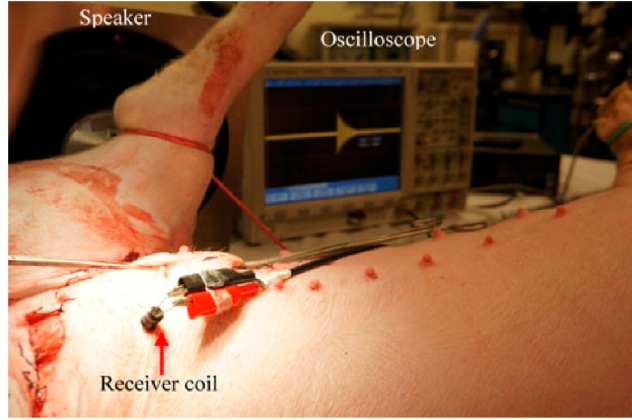
Figure 47. Photograph of in vivo experiment inside pig’s bladder [203].